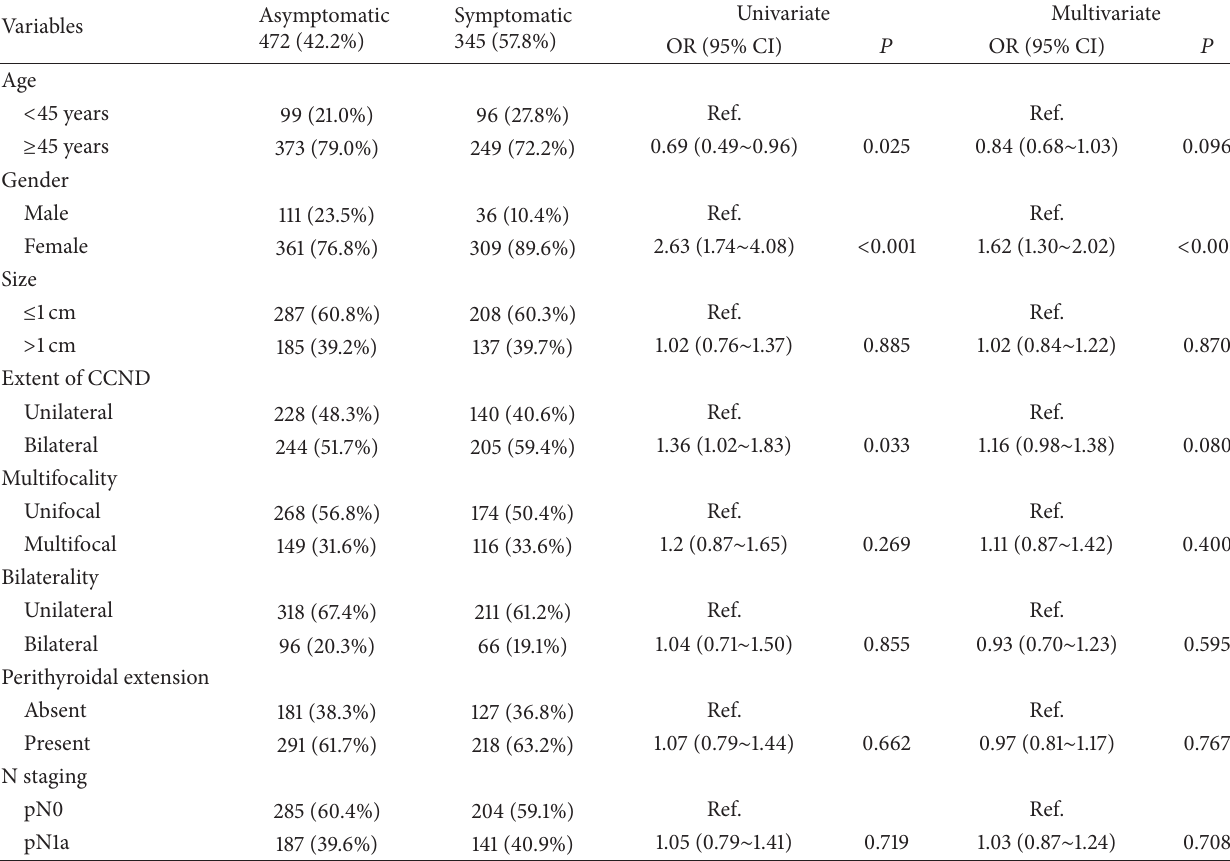
Table 1: Univariate and multivariate clinicopathological risk factor analysis for the development of hypocalcemic